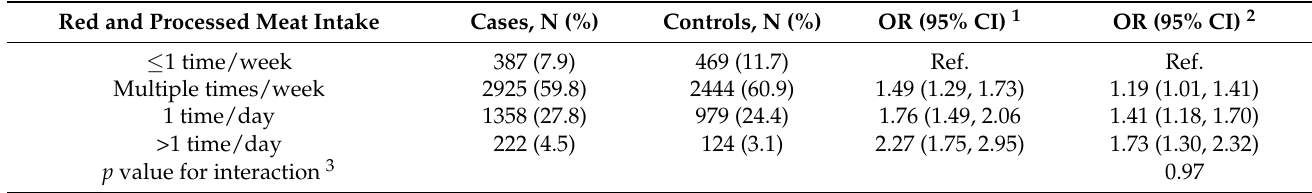
Table 2. Association of red and processed meat intake with colorectal cancer risk in the whole study